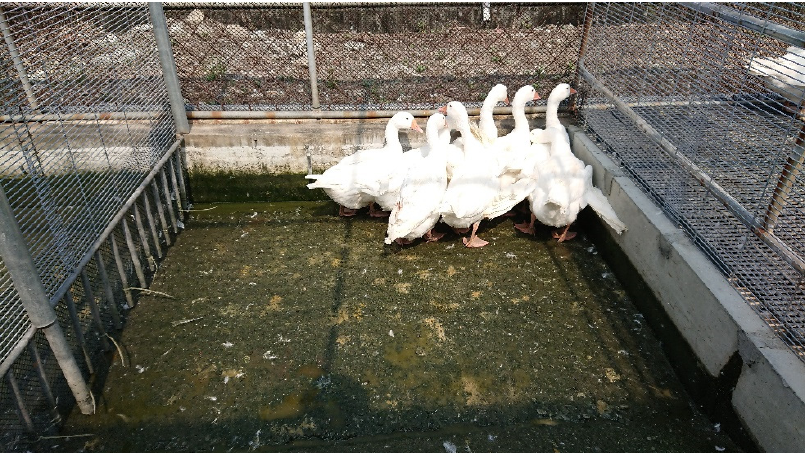
Figure 2. The swimming pools of the pens in this experiment. The plastic greenhouse film was used at the top of the swimming pool to provide natural light. The pool measured 2.57 m long and 2.10 m wide, respectively. Its deepest point is 38 cm, and at its entrance there is a gentle slope so that the geese can enter slowly.